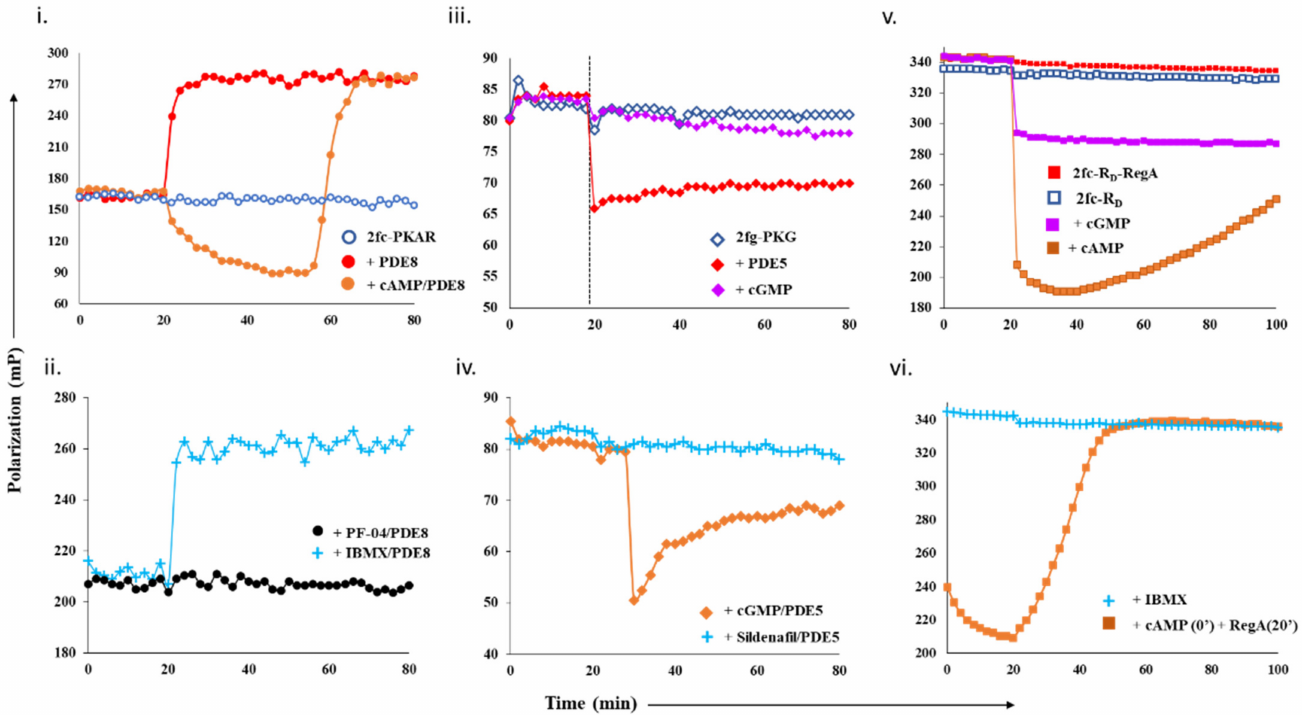
Figure 1. Design and test of competitive displacement assay using PDE–PK complexes. ( i , ii ) cAMP-specific probe PDE8– PKAR: ( i ) active PDE8c (red circles) and cAMP-saturated PDE8c (orange circles) were added to 2fc-PKAR at 20 min interval, and the FP values were measured; ( ii ) inhibition and complexation of cAMP-specific PDE8–PKAR were tested by the addition of PDE8c (1 µ M) incubated with 10 µ M PF-04957325 (black circles) and 500 µ M IBMX (cyan plus) to 2fc-PKAR at t = 20 min. ( iii , iv ) cGMP-specific probe PDE5–PKG: ( iii ) at 20 min time interval, PDE5 (red diamonds) and cGMP (lilac diamonds) were added to 2fg-PKG (blue circles), and the signal was measured for a total time course of 80 min; ( iv ) PDE5 was incubated with substrate 100 µ M cGMP (orange diamonds) and 1 µ M sildenafil (cyan plus) and added to 2fg-PKG at time t = 30 min to test stability and inhibition of cGMP-specific PDE5–PKG probe. ( v , vi ) Dual-specificity probe RegA-R D : ( v ) Plot showing stability of preformed composite active sites of 2fc-R D -RegA (red squares) as compared to free 2fc-R D (blue squares). Excess cAMP (orange squares) and cGMP (lilac squares) were added to 2fc-R D -RegA complex at 20 min interval and FP measured for further 80 min. ( vi ) At t = 20 min, IBMX (cyan plus) was added to 2fc-R D . Separately, cAMP was added to 2fc-R D at time = 0 min, followed by RegA at time = 20 min, to this reaction mixture (orange squares), and FP was measured for a time course of 100